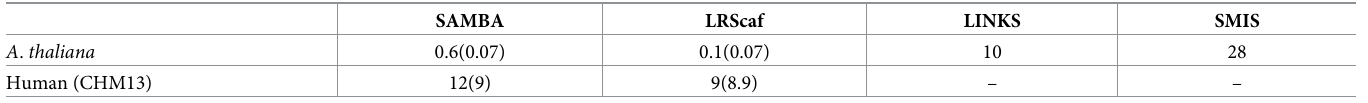
Table 3. Total wall clock time (in hours) that each tool required for scaffolding the Arabidopsis and human assemblies with 30x coverage by long reads on a 24-core Intel(R) Xeon(R) 6248R server with 512 GB of RAM. In parentheses we list the time required for the alignment of the long reads for SAMBA and LRScaf.